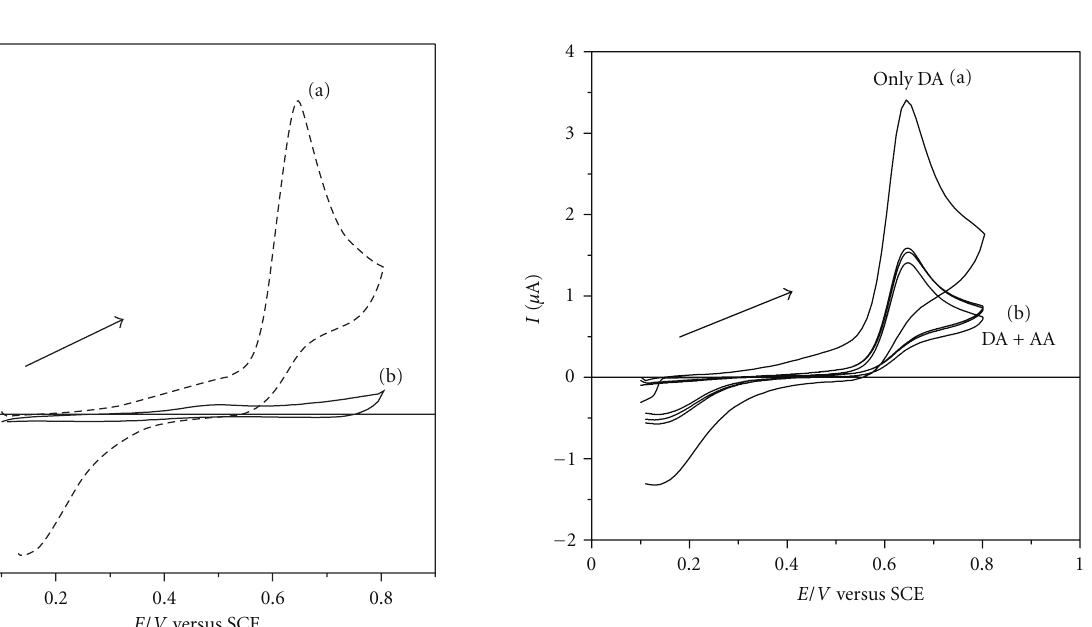
Figure 7: Interferent detection test: cyclic voltammograms for ITO/(DS 01/NiTsPc) 3 film in (a) 1.9608 × 10 − 5 molL − 1 of DA and (b) in presence of DA (1.9608 × 10 − 5 molL − 1 ) and AA simul- taneously, in di ff erent proportions C DA /C AA : 1 :1, 1:2, and